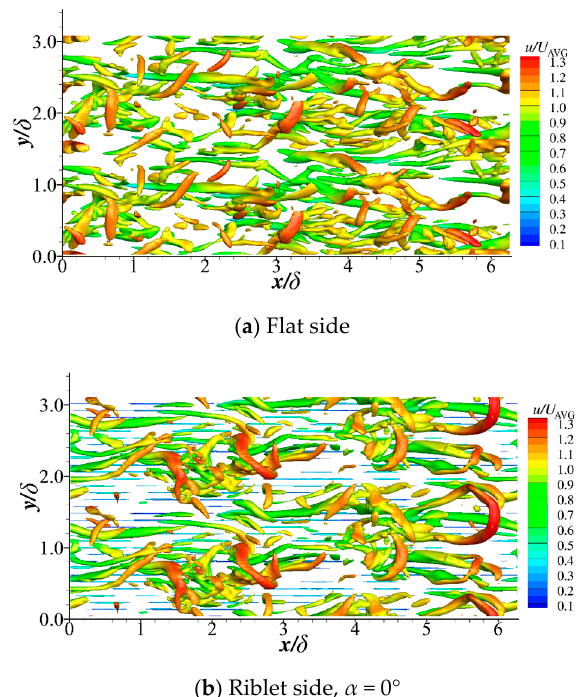
Figure 5. Root mean squares of the velocities and the Reynolds shear stresses of the